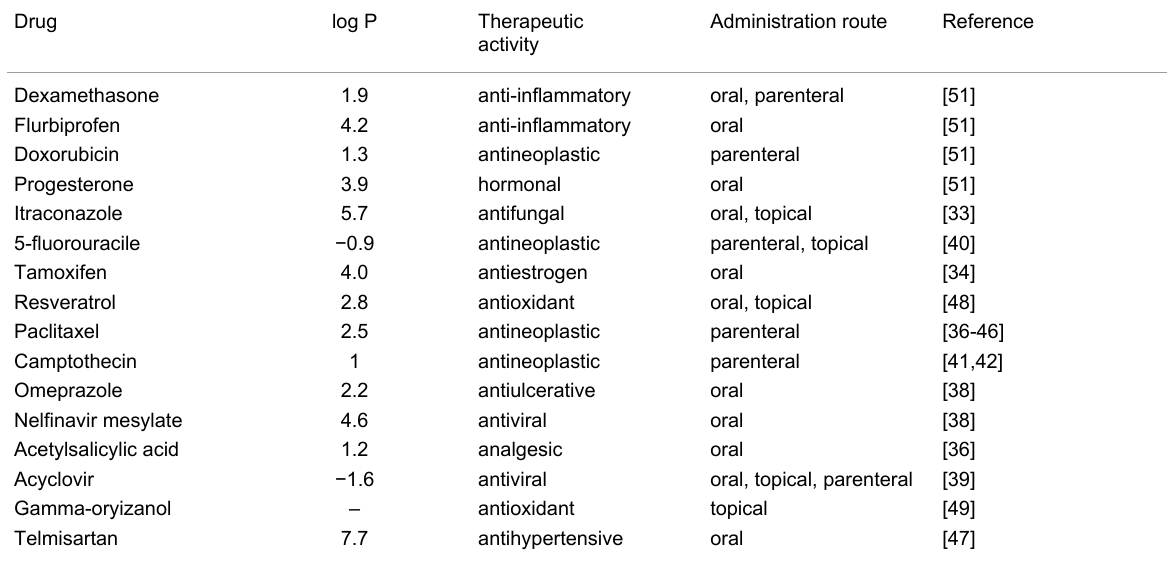
Table 1: Molecules complexed by using nanosponges. Drug log P Therapeutic